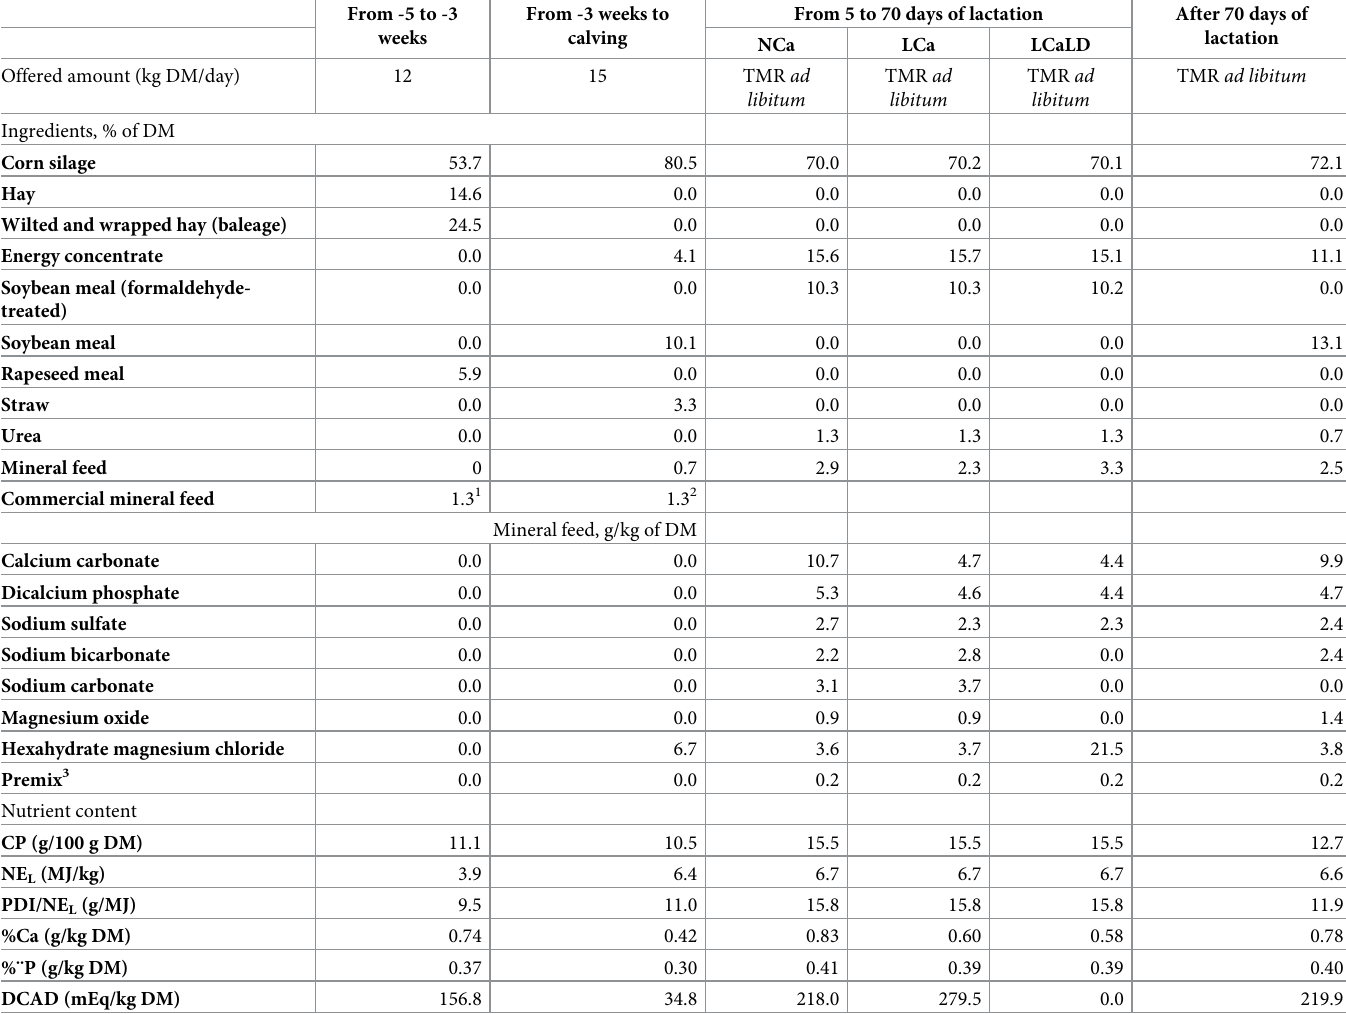
Table 1. Dietary centesimal composition and nutritional